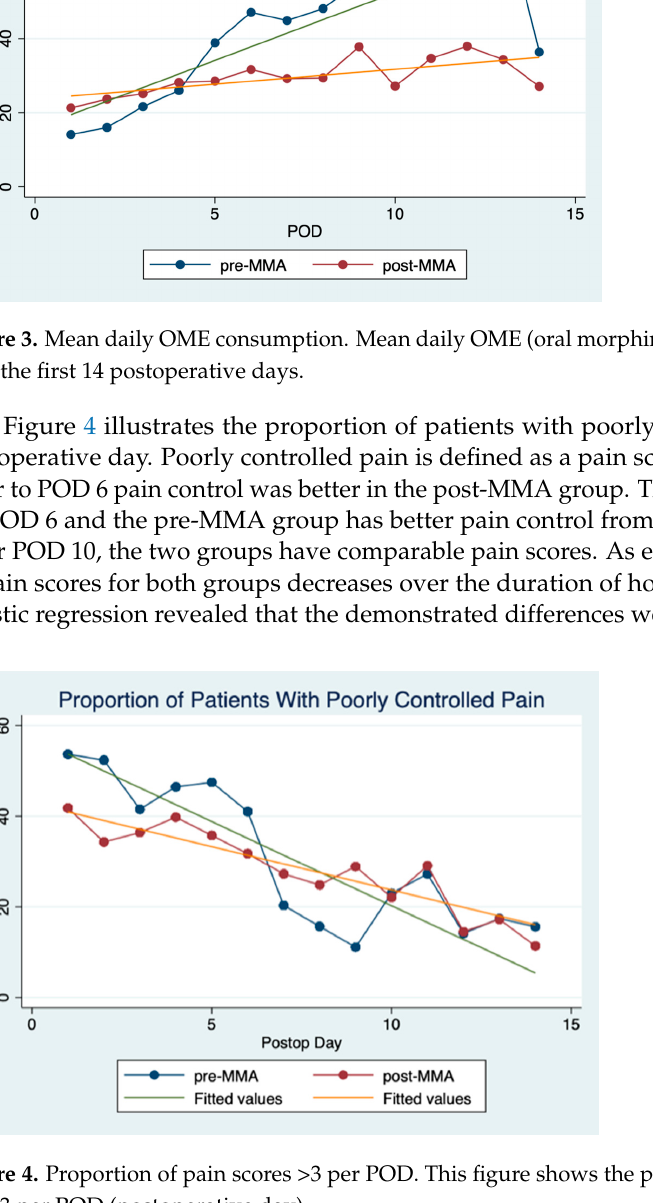
are >3 per POD (postoperative